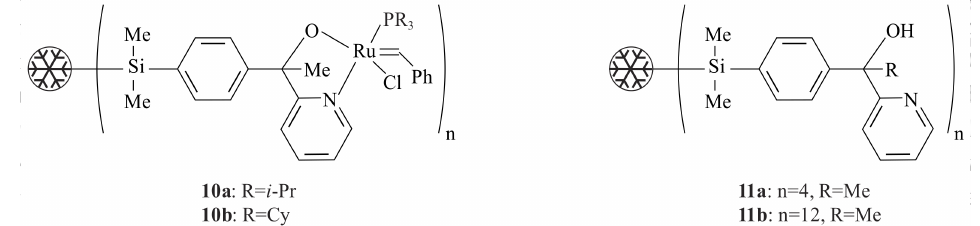
Figure 3. Dendritic pyridinyl alcohols and Ru complexes.